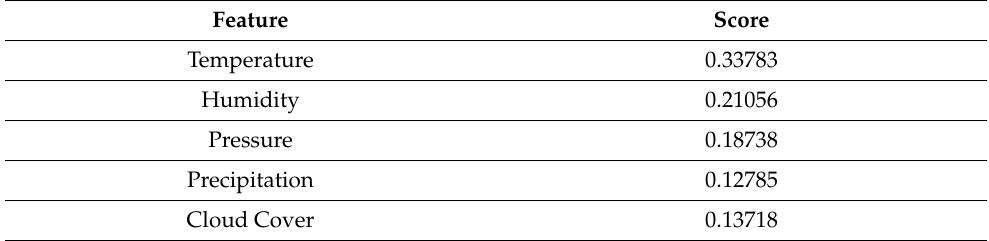
Table 3. Random Forest model feature